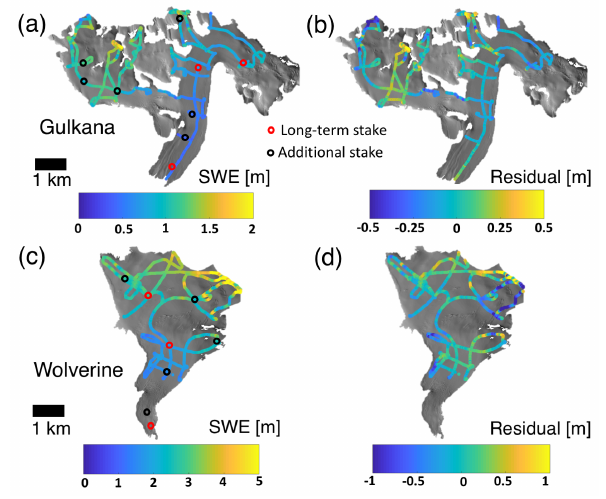
Figure 3. GPR surveys from 2015 at Gulkana (a) and Wolverine (c) glaciers and MVR model residuals (b, d)